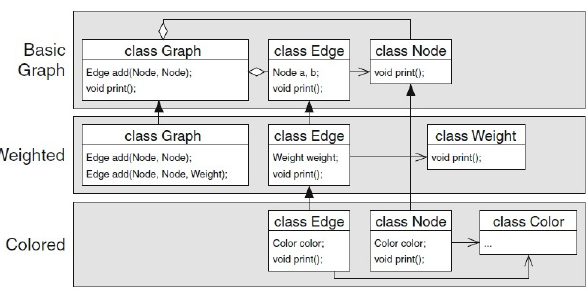
Figure 3: Feature model of a graph